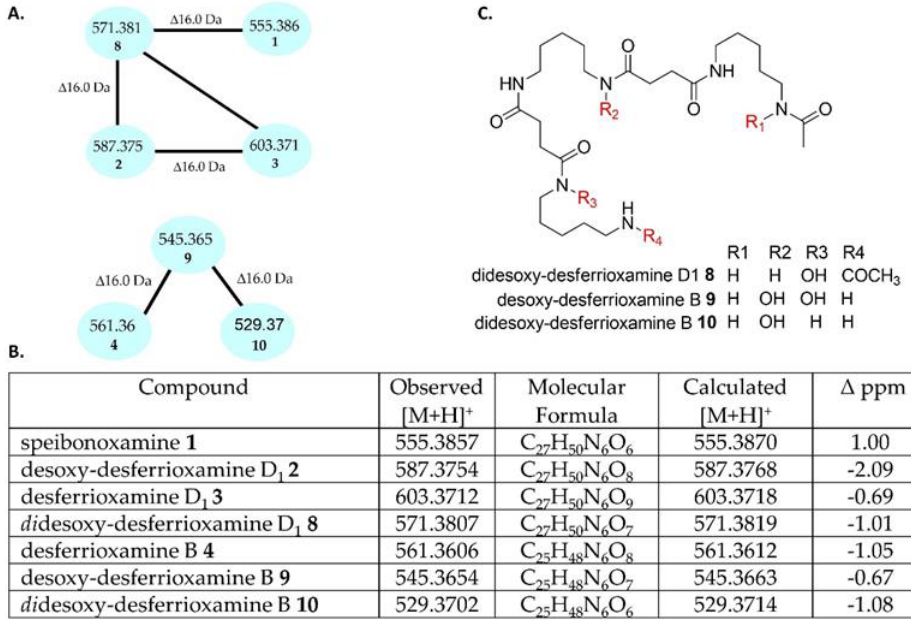
Figure 2. ( A ) Specific subnetwork analysis of the K. speibonae strain SK5; ( B ) putative dehydroxylated desferrioxamine analogues D 1 8 and B 9 – 10 ; ( C ) structures of plausible desferrioxamines 8 – 10 determined by the MS/MS fragmentation pattern.